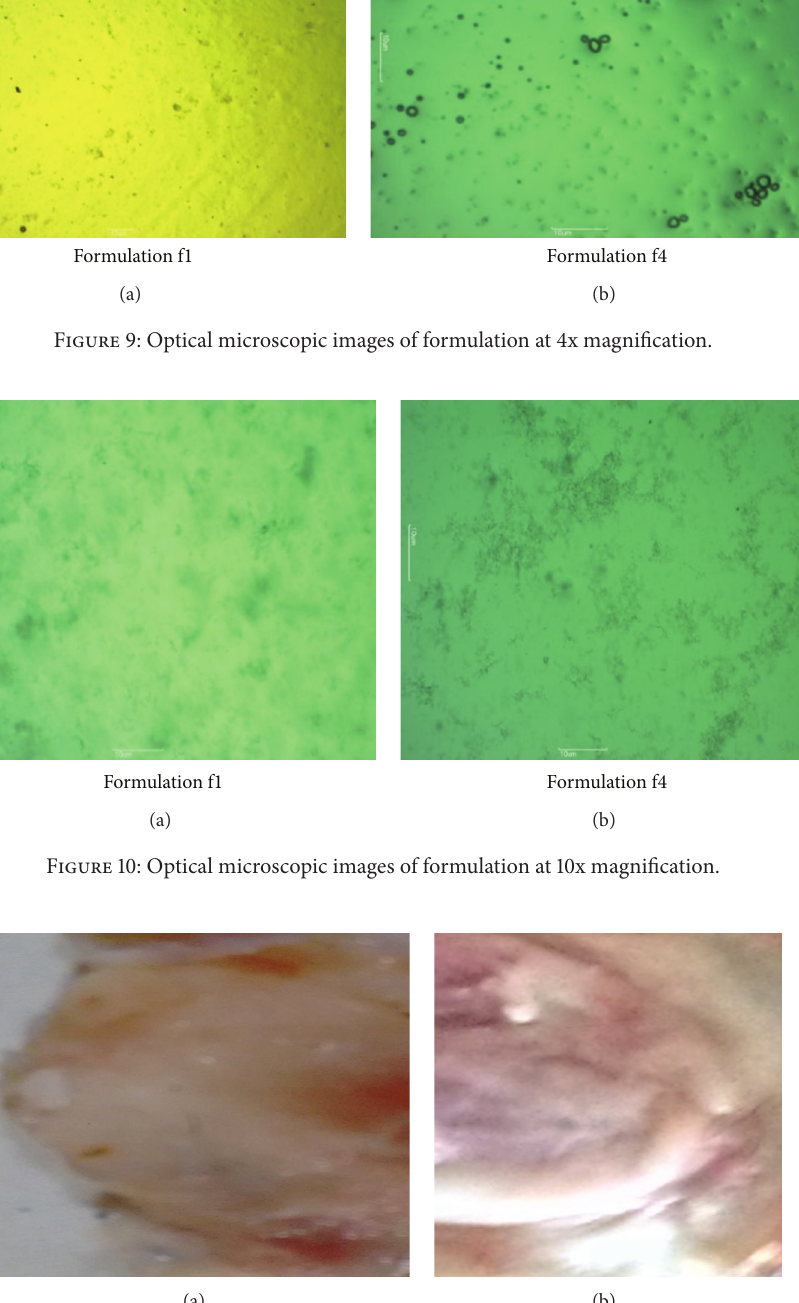
release nasal gel for timolol maleate. f1 and f4 gave